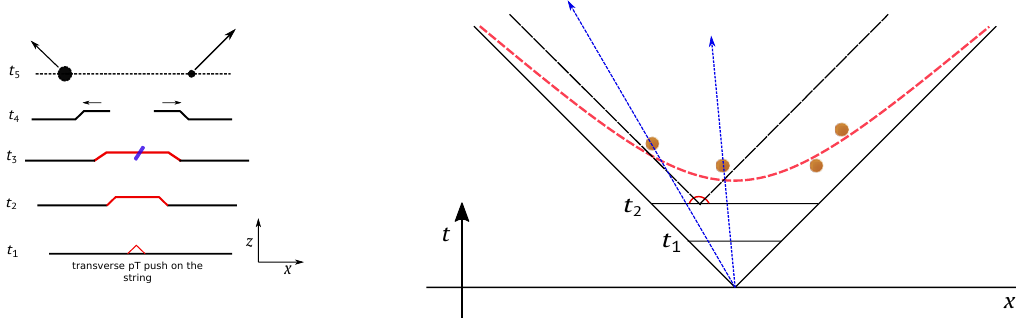
Figure 6 . The left figure illustrates how a nudge deforms the geometry of a string piece from the time it is applied until the string breaks. The right figure illustrates how the final state hadrons that are formed will share the transverse momentum of a nudge are